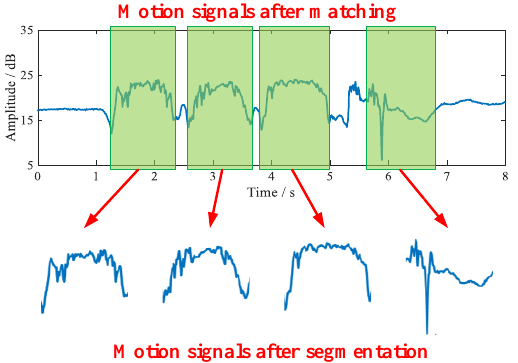
Figure 7. Motion signal segmentation.